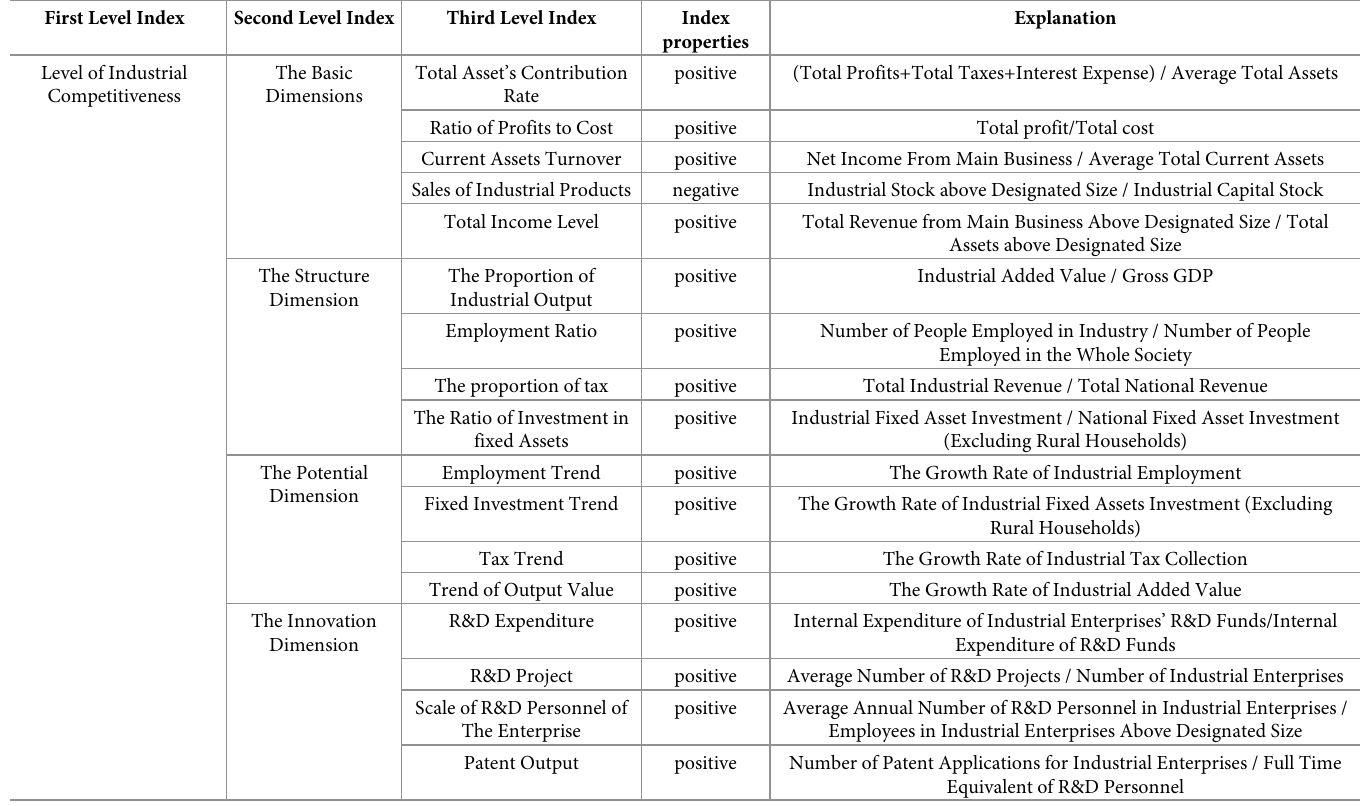
Table 2. Multidimensional niche evaluation index system of industrial competitiveness.